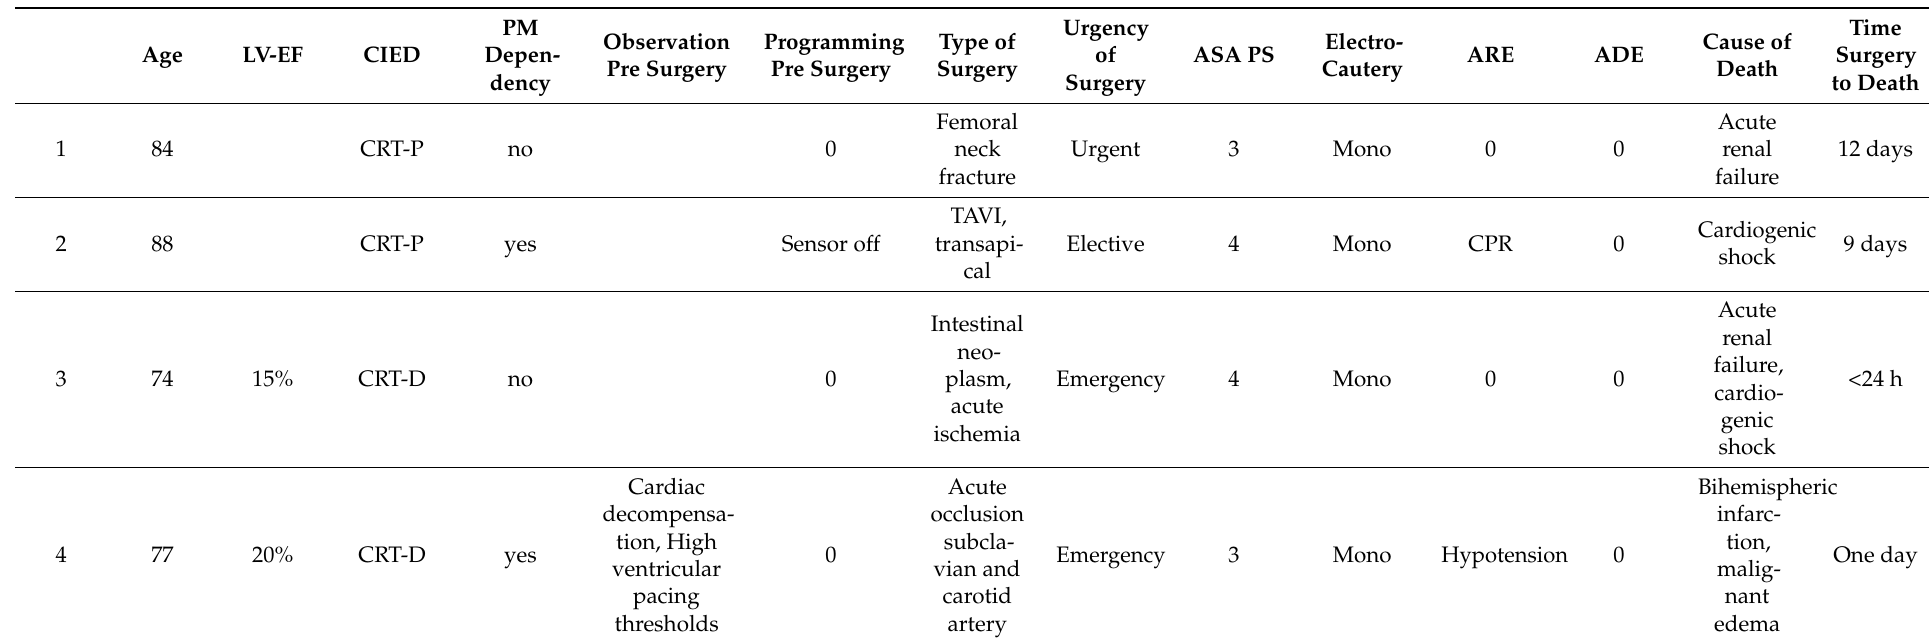
Table 11. Peri-interventional mortality in CRT